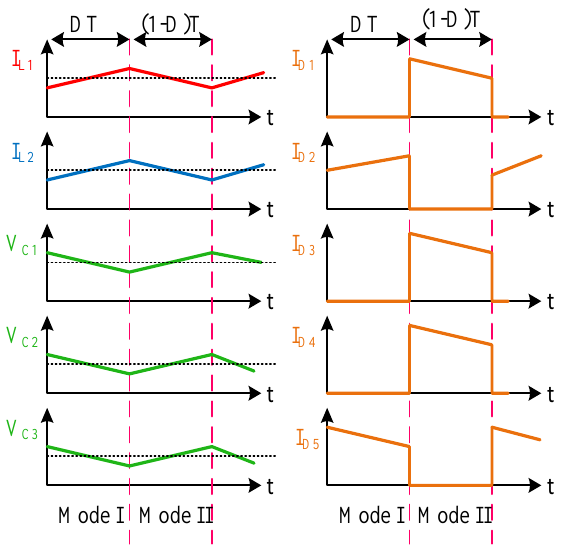
Figure 5. Typical waveforms of the proposed converter II in CCM.